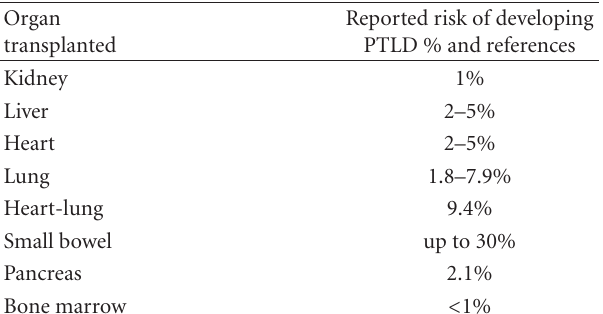
Table 1: Frequency of PTLD in di ff erent types of